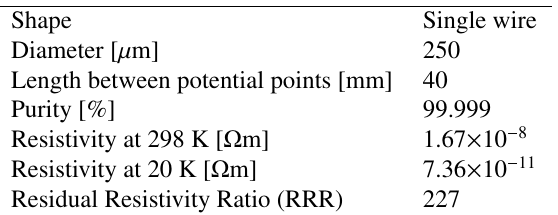
Table 1. Characteristics of copper